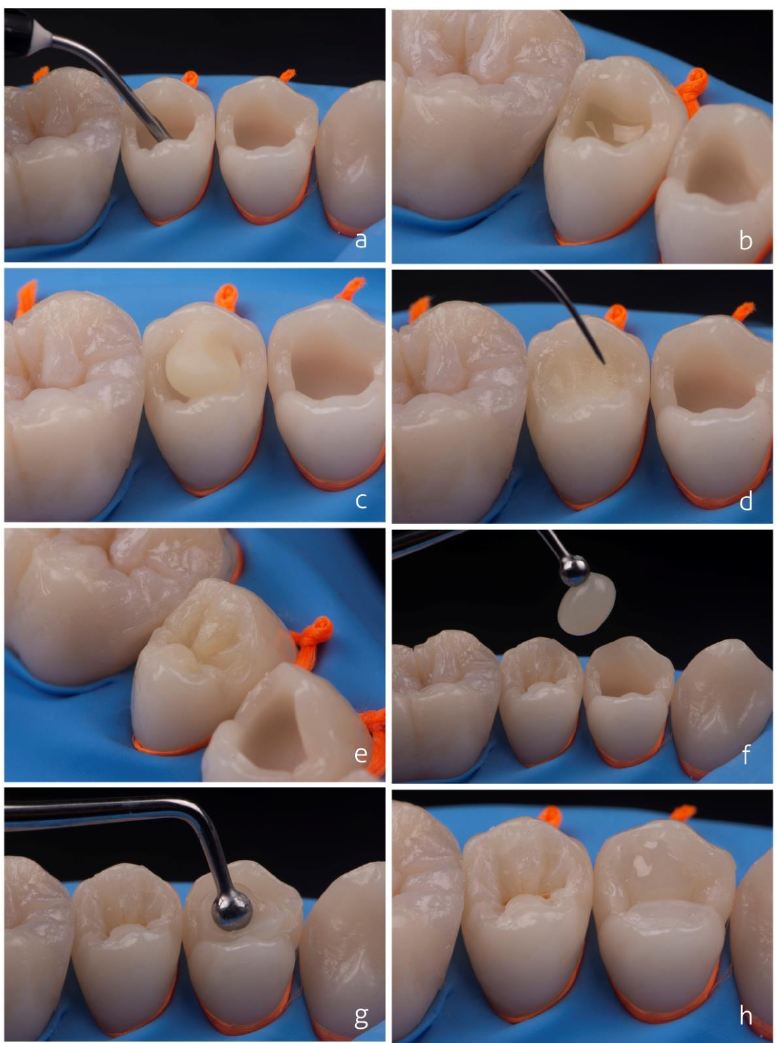
Figure 8. Examples of ‘bulk and body’ and ‘bulk and go’ restorative techniques. Bulk and body: restoring the dentin portion of the cavity with flowable bulk-fill composite ( a , b ), insertion of enamel composite ( c ), sculpture ( d ), and final aspect ( e ). Bulk and go: insertion of regular bulk-fill composite as single increment ( f ), accommodation of the increment ( g ), and final aspect of the sculpture ( h ).